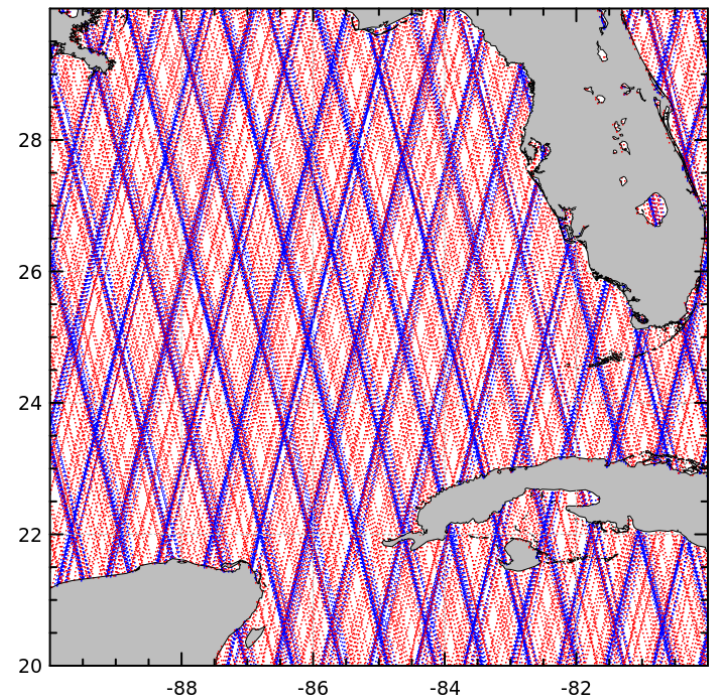
Figure 1. Blue: Repetitive orbit ground track. Red: Drifting orbit ground